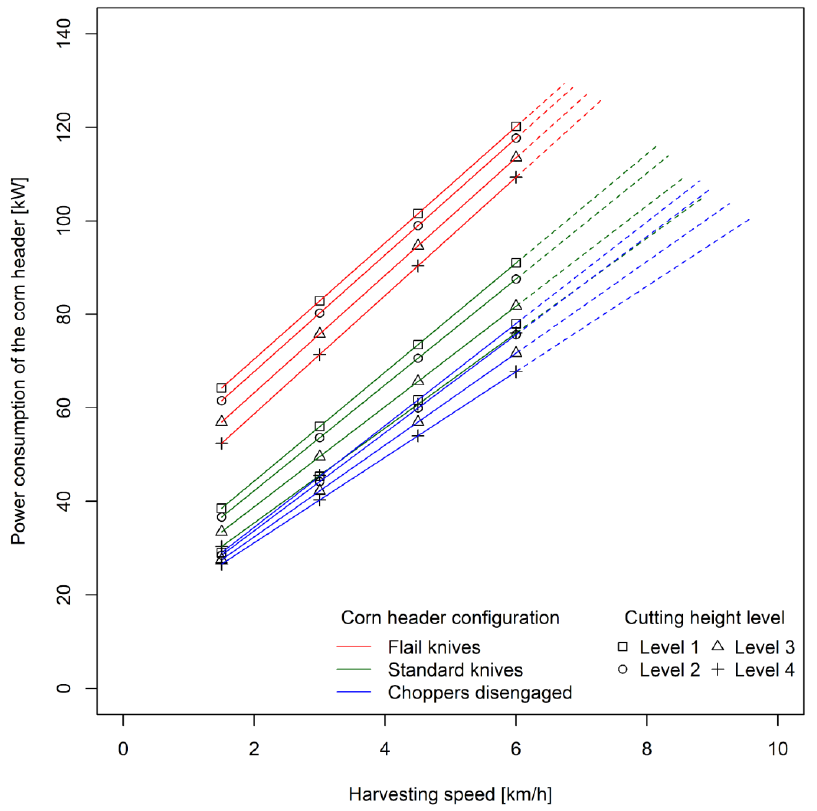
Figure 3. Power consumption of the corn header depending on harvesting speed for the different levels of corn header configuration and cutting height.